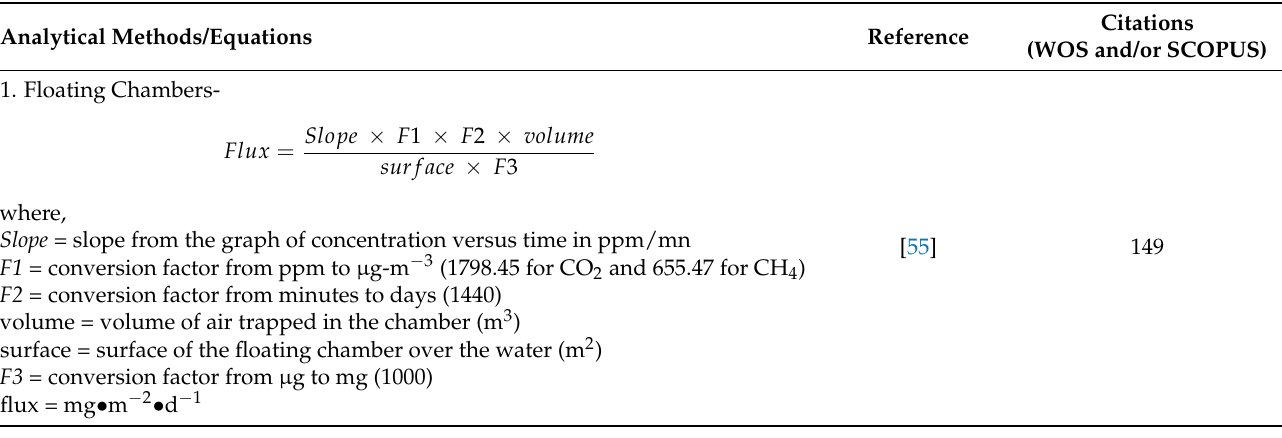
Table 3. Analytical methods/equations for measuring GHG emissions from waterbodies.